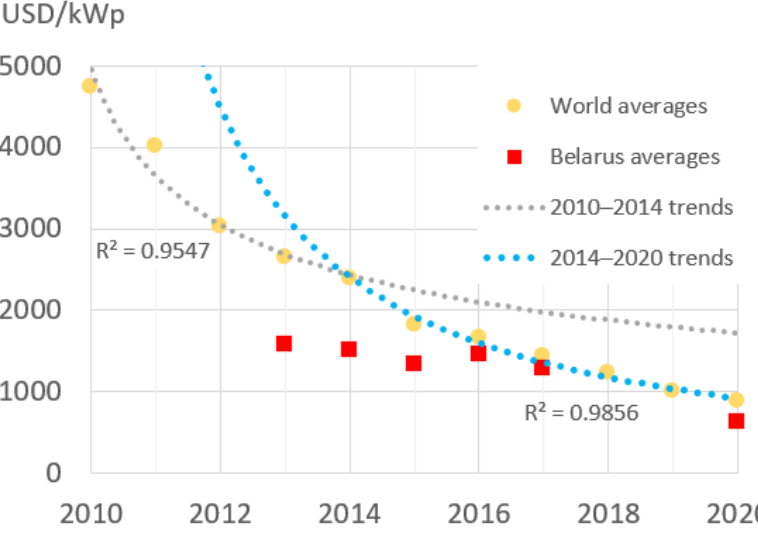
Figure 5. Dynamics of the average unit cost of solar power plant construction in the world and in Belarus.